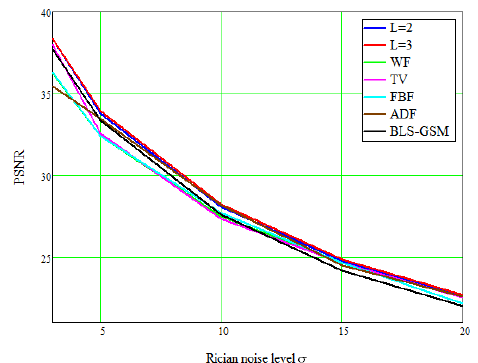
Figure 4. Comparison of measurements PSNR of methods with different Rician noise levels